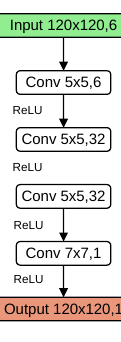
Figure 6. Tested CNN architecture.